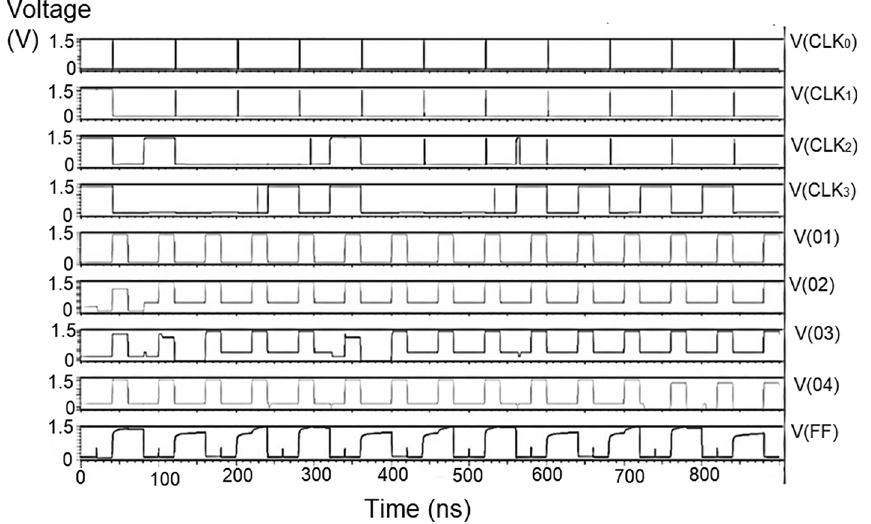
Figure 8(c). Voltage vs. time simulation at 1.5 V for 180 nm.